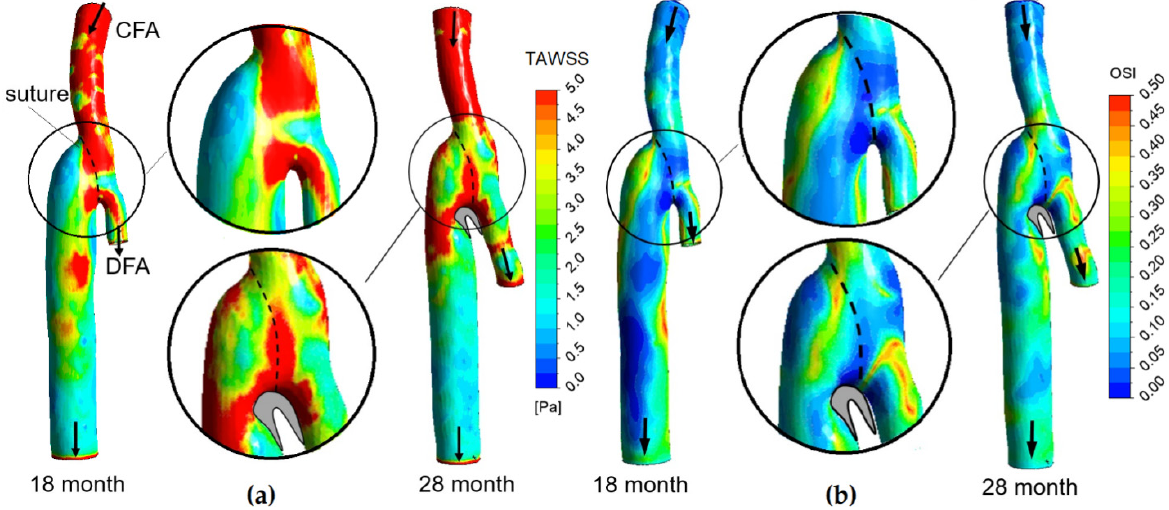
Figure 11. ( a ) TAWSS and ( b ) OSI distributions for the models related to 18 and 28 months after bypass surgery. Arrows indicate the blood flow direction.